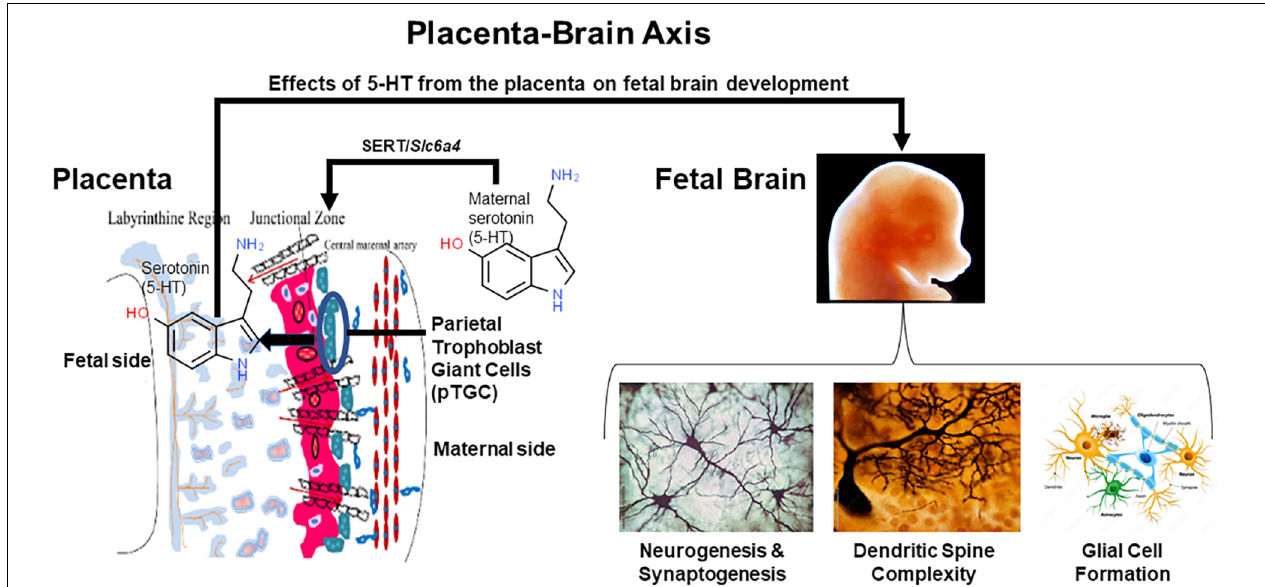
FIGURE 1 | The placenta-brain axis and effects of placental 5-HT on fetal brain development. The parietal trophoblast giant cells (pTGC) in the fetal placenta may amass maternal 5-HT via SERT or may synthesize this morphogen. Placental-derived 5-HT may then act upon the developing fetal brain to promote neurogenesis, synaptogenesis, increase dendritic spine complexity, and glial cell formation. In essence, early embryology and brain development may depend upon 5-HT originating from the placenta.